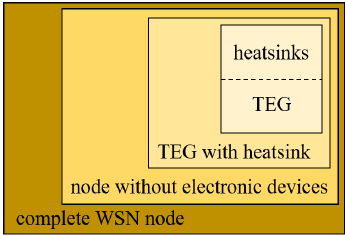
Figure 5. Block diagram of the model verification